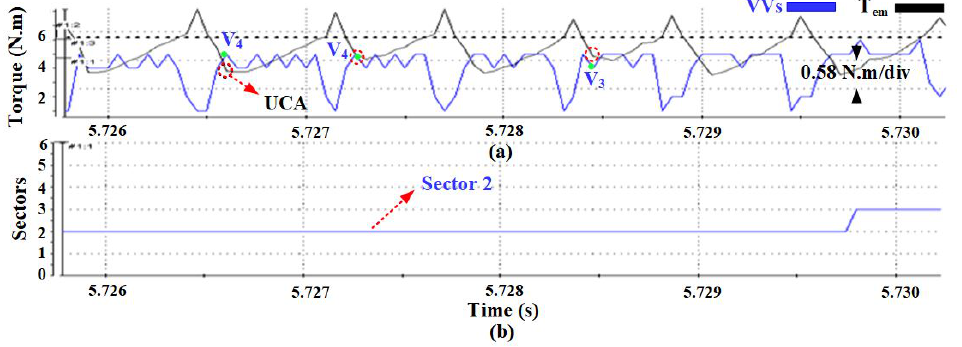
Figure 28. ( a ) Torque response towards VVs and ( b ) sector 2.